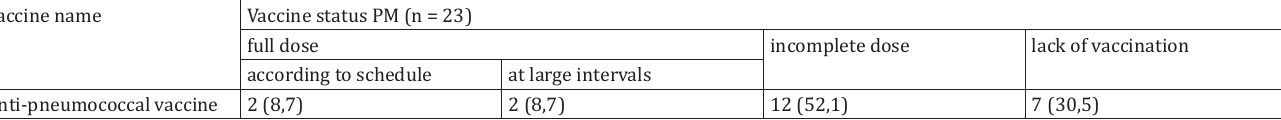
Vaccine status in children with PM for 2015-2018